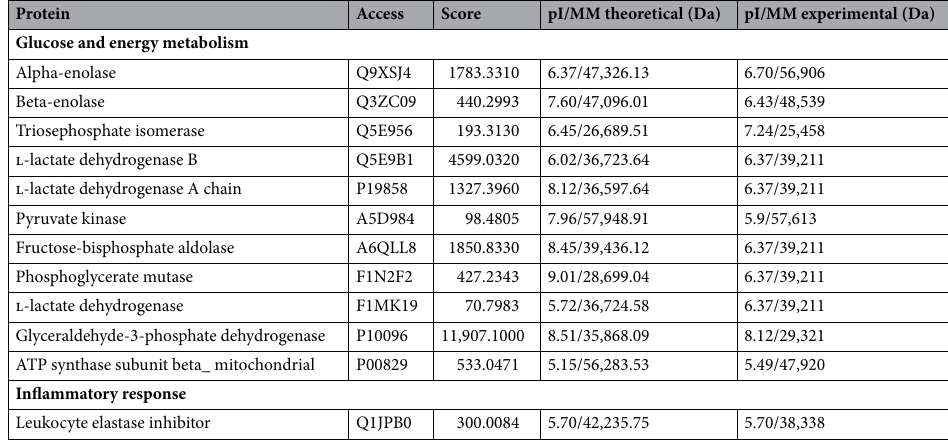
Table 2. Proteins identified by LC–MS/MS in protein spots differentially expressed in Nellore bovine cecum fed on diets containing increasing levels of starch (25, 35 and 45%) and additives (monensin, blend essential oil + exogenous α-amylase).